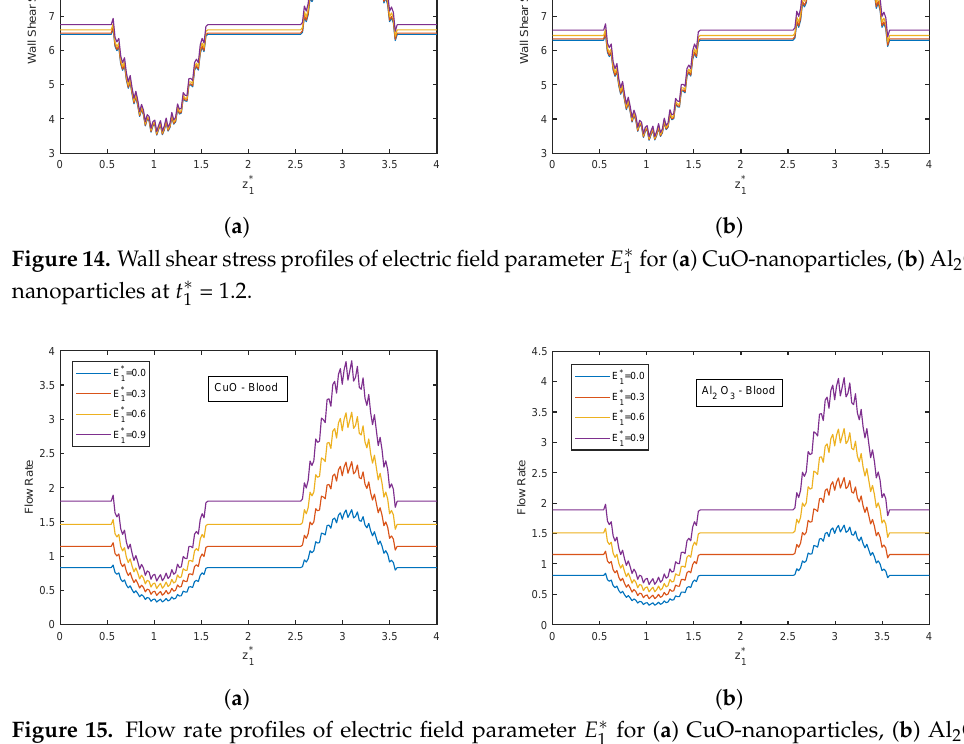
for ( a ) CuO-nanoparticles, ( b ) Al 2 O 3 - 1